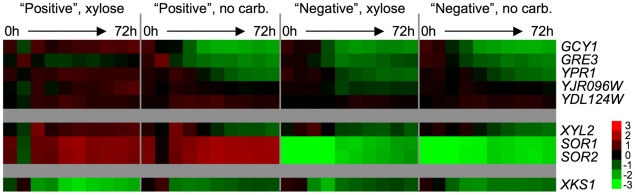
Endogenous xylose pathway gene expression.Relative mRNA abundance (compared to a pooled reference of all samples) for putative xylose pathway genes. Values are average Log2(sample/reference) ratios among 3 biological replicates for each time point. Time 0 is immediately following inoculation from a saturated YPD culture into “xylose” (2% xylose in minimal media) or “no carb.” (no carbon source in minimal media). Time points were taken every 8 hours for 72 hours.